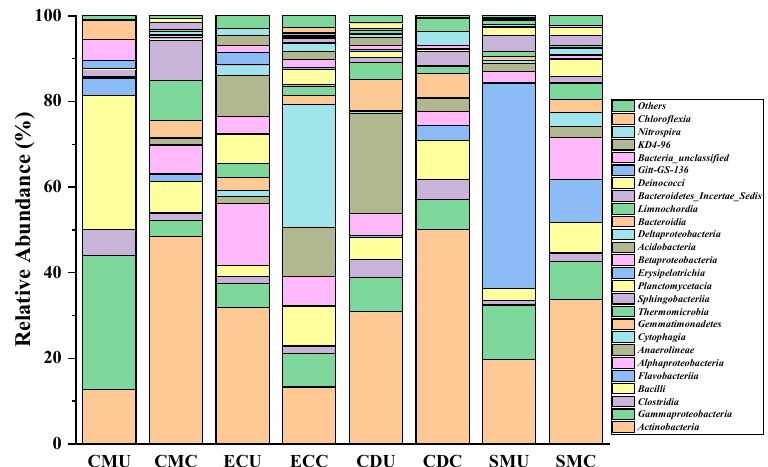
Figure 2. The effect of composting on the composition of organic fertilizer microbial community. The composition of the microbial community at the class level. Only the most abundant taxa (>1% genus) are displayed. The order of the genes is based on their relative abundance (mean, n = 3).